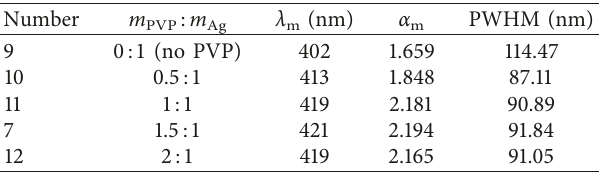
Table 3: Test results of AgNPs synthesized under different PVP